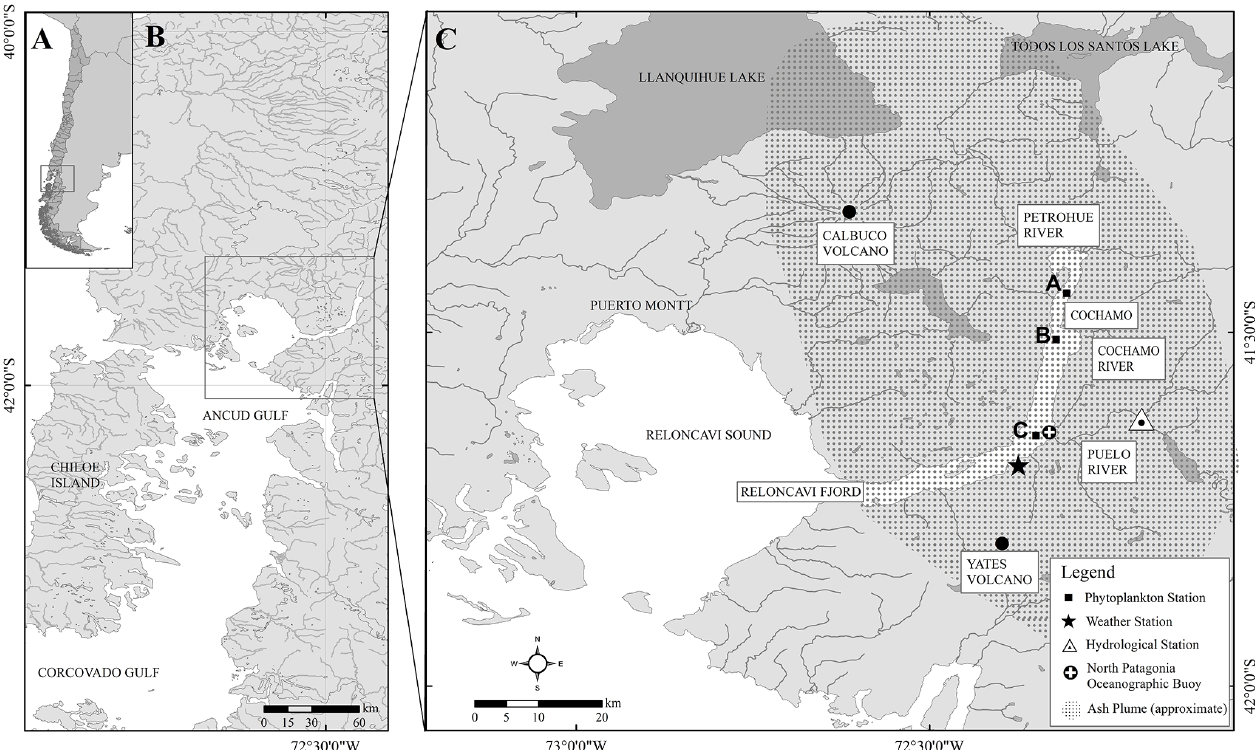
Figure 1. The Calbuco region showing the location of Reloncaví Fjord, three major rivers (the Petrohué, Cochamó and Puelo) discharging into the fjord, the three stations (black squares; panel c ) used to assess changes in phytoplankton abundance following the eruption, a hydrological station that monitors the Puelo River flow, a weather station and the location of a long-term mooring within the fjord. The approximate extent of the ash plume in the week following the first eruption is illustrated, as estimated in technical reports issued by the Servicio Nacional de Geología y Minería